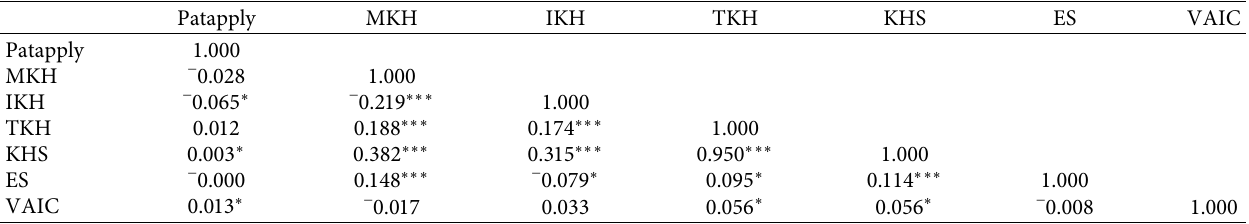
Table 4: Correlation matrix for main study variables.